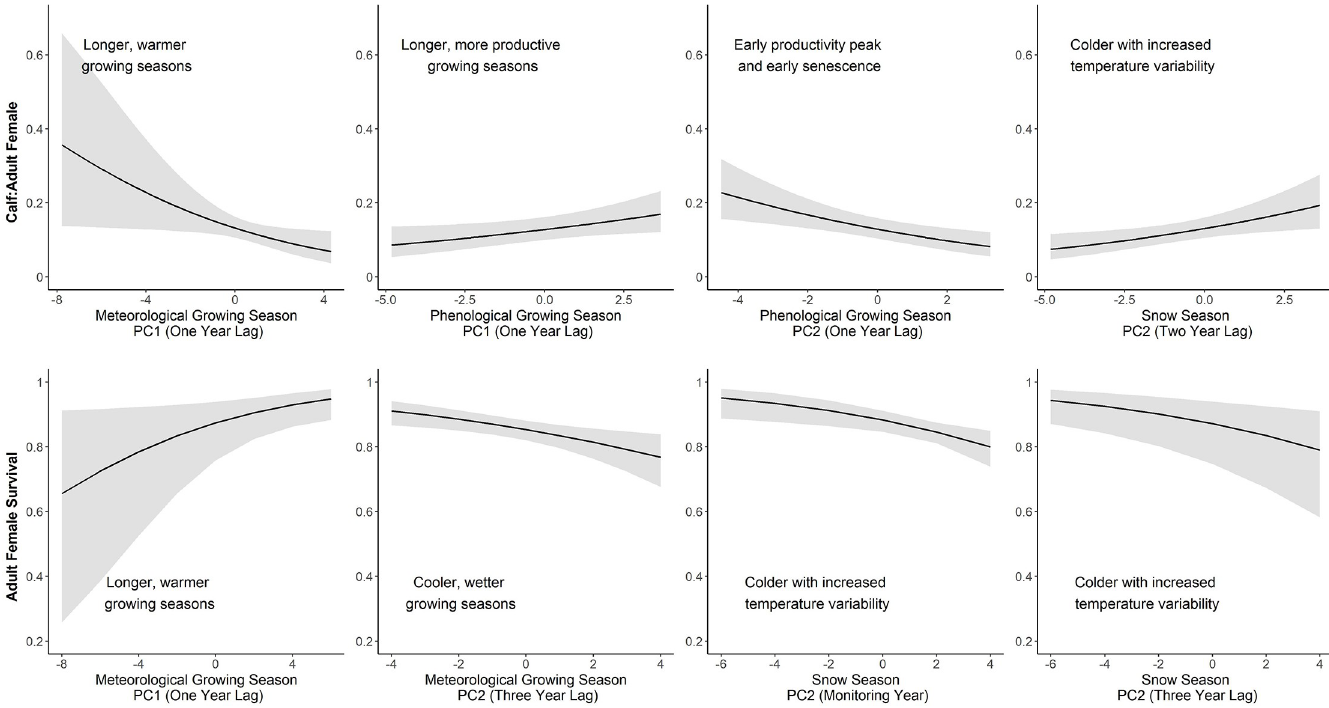
Fig 5. Predicted responses (with 95% CIs) of caribou demographic rates (calf: Adult female ratios and adult female survival) to principal components (PCs) representing various meteorological and phenological variables. Principal components shown are those with parameter estimates having 95% confidence intervals that did not overlap zero. For each facet, descriptions are provided for the referenced principal component. Note that x-axes vary among facets.